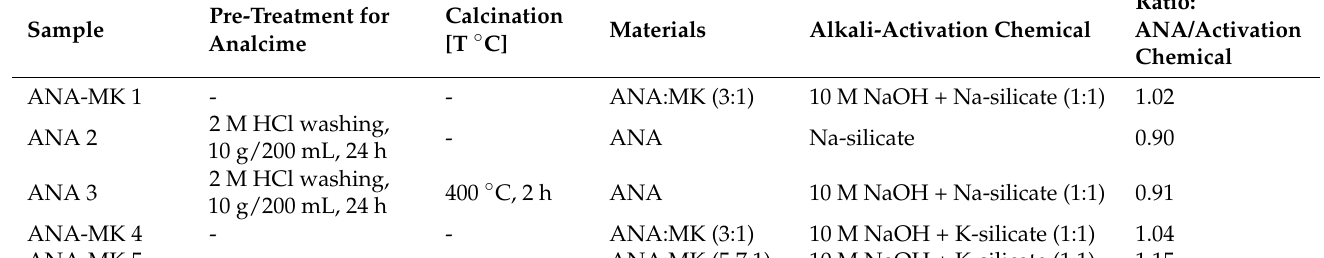
Table 2. Production conditions for the alkali-activated analcime sorbents.